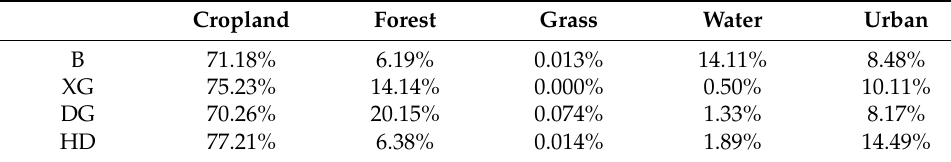
Table 2. Land-use distribution in the Baoan Lake basin and its sub-basins. Cropland Forest